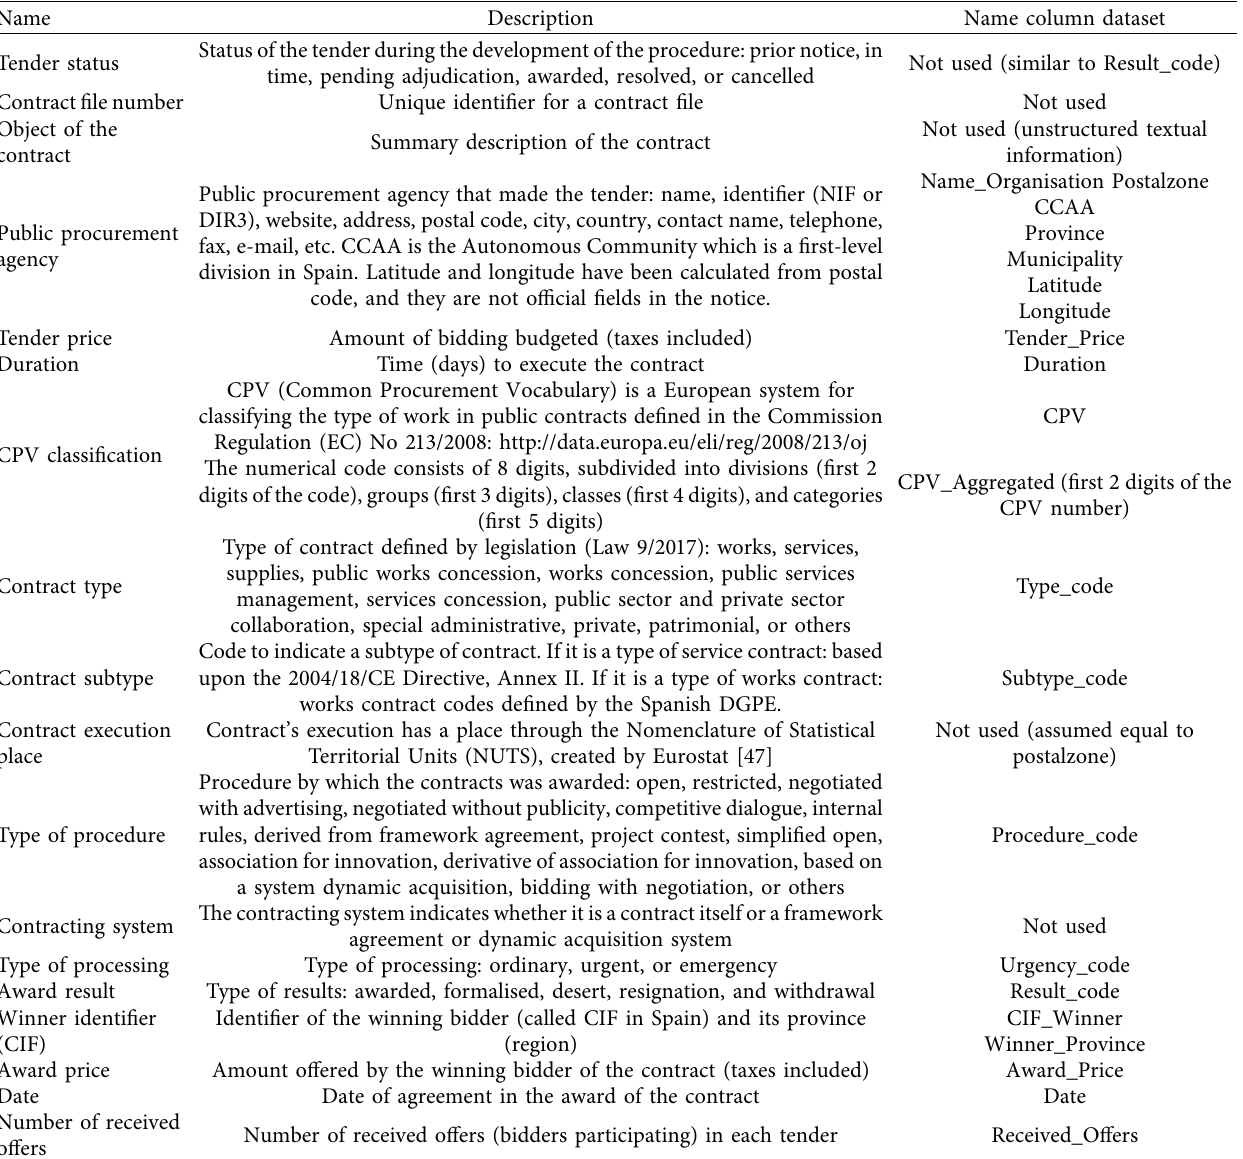
Table 1: Most relevant data fields in the Spanish Public Procurement Notices (tenders) used in the